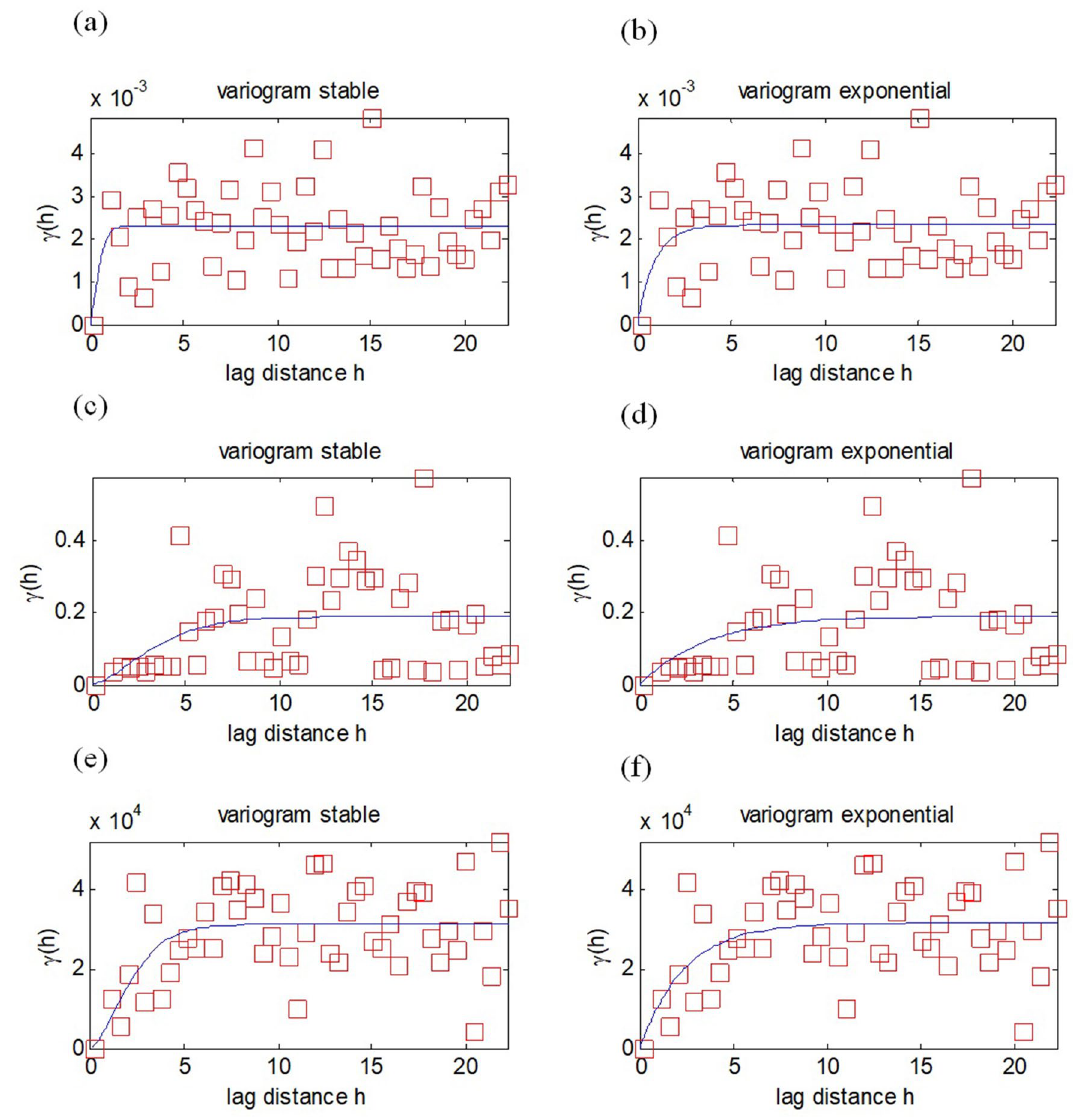
Figure 5. Semivariogram of geomagnetic data from epoch 2010 for the OK method. Clustered overlapping experimental variograms as characteristic of the clustered distributed data pattern, resulting in identical theoretical variogram parameters between stable and exponential. ( a ) stable variogram of declination comp., ( b ) exponential variogram of declination comp., ( c ) stable variogram of inclination comp., ( d ) exponential variogram of inclination comp., ( e ) stable variogram of total intensity comp., and ( f ) exponential variogram of total intensity